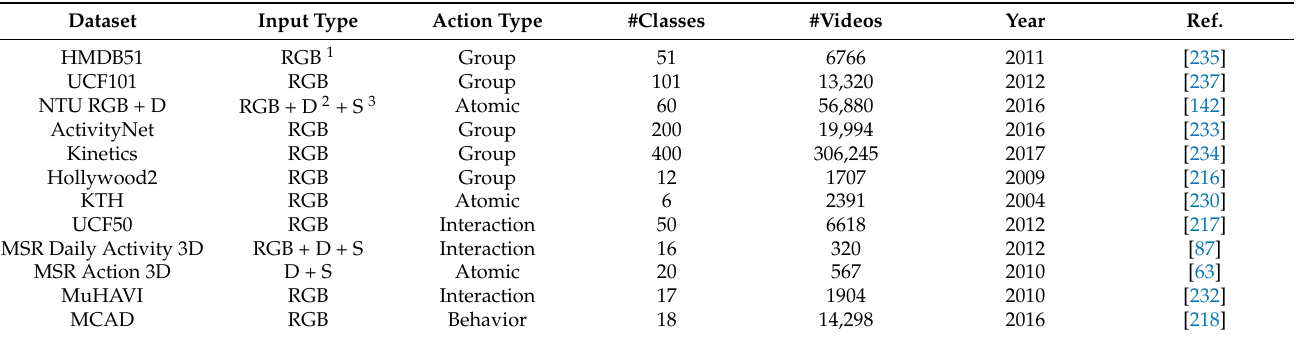
Table 4. Polular Public